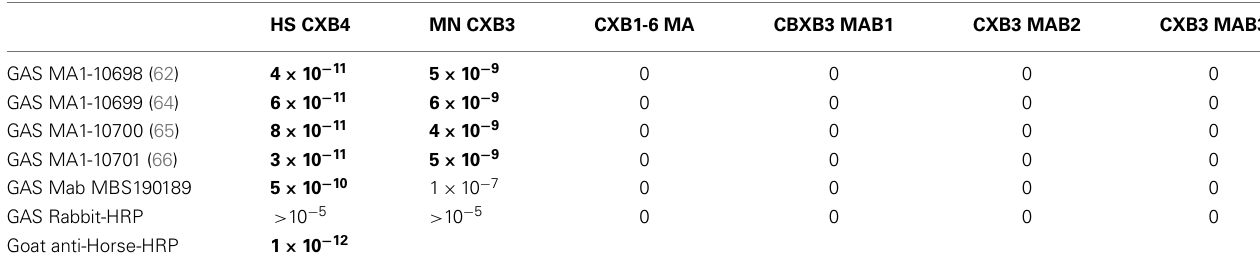
Table 4 | Results of double-antibody (DA)-ELISA experiments and Ouchterlony immunodiffusion experiments involving GAS (groupA streptococcus) antibodies binding to CX (coxsackie virus) antibodies .